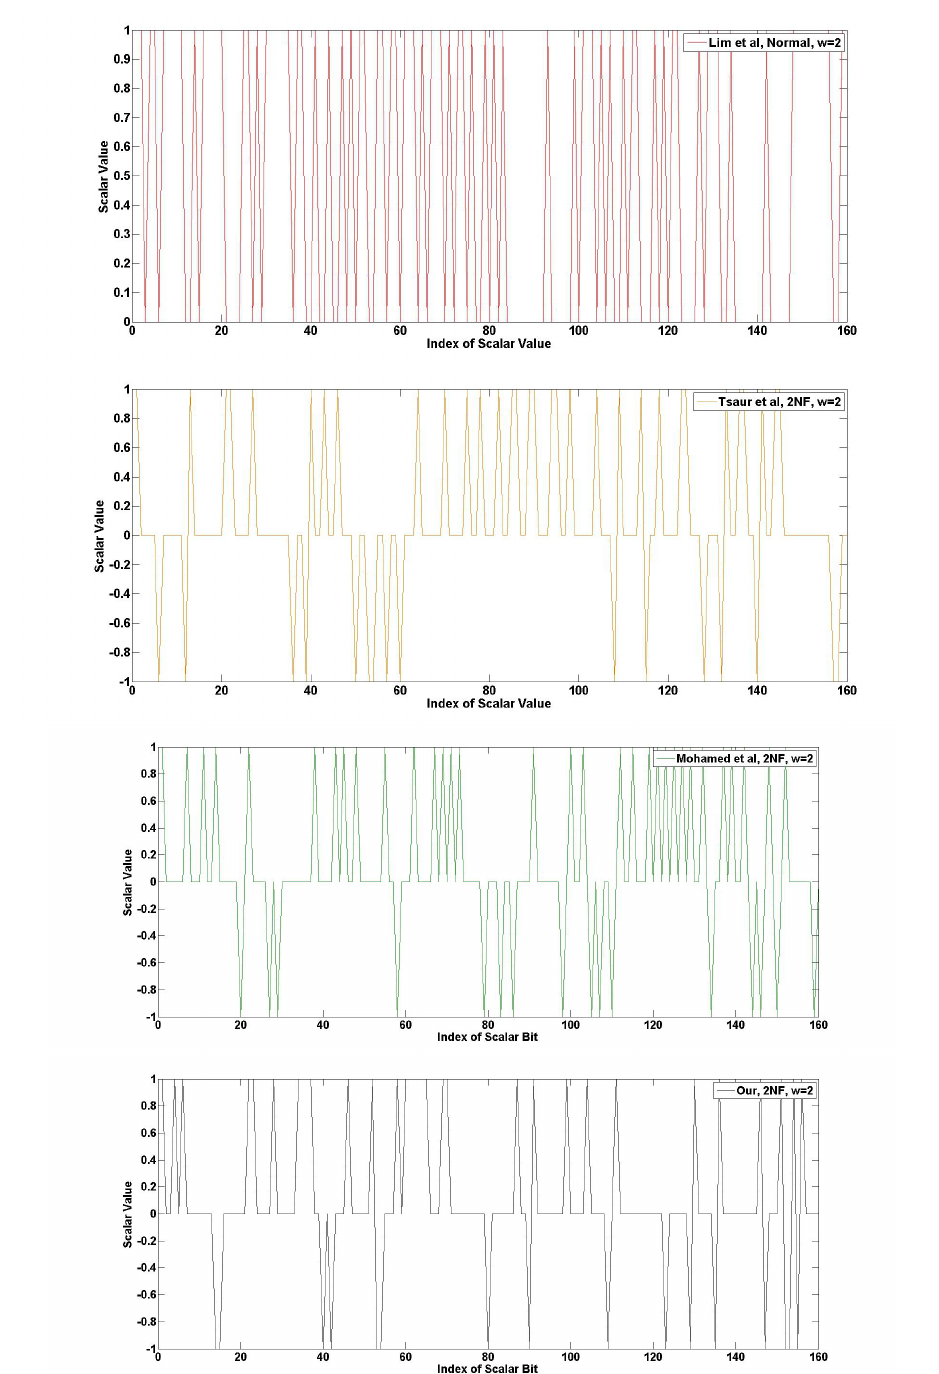
Figure 14. Frequency of scalar value represented in